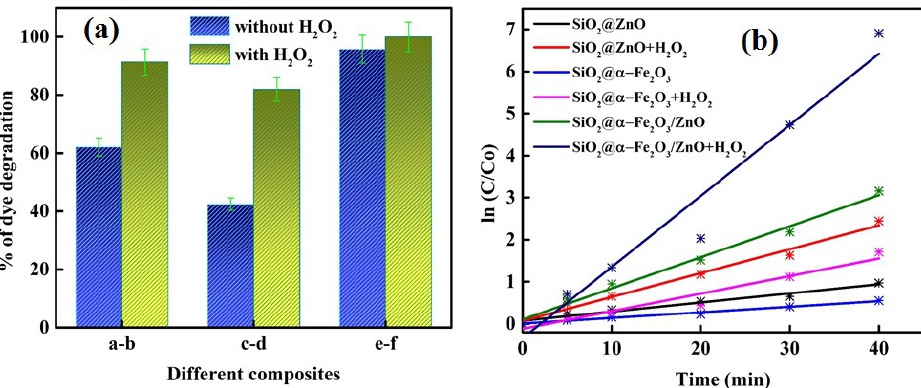
Figure 7. ( a ) Photo-Fenton degradation of MB using different nanocomposites with and without H 2 O 2 :